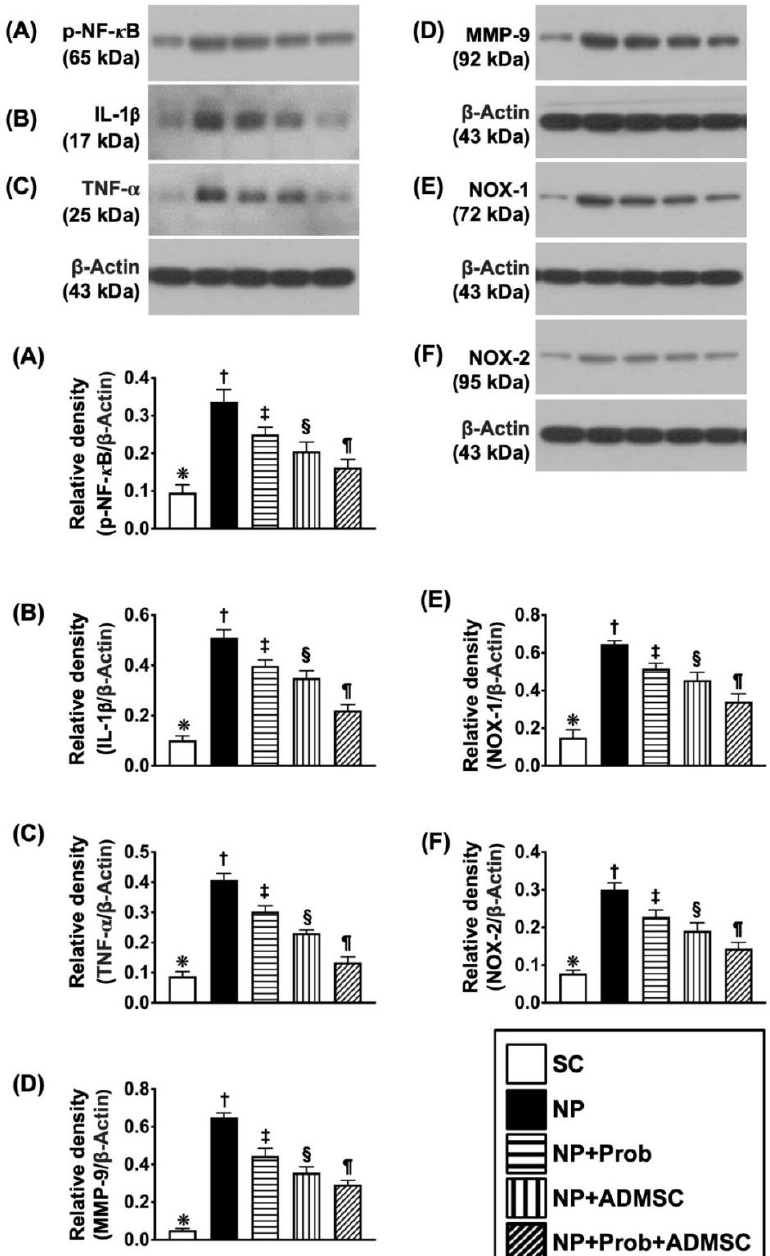
Figure 3. Protein expressions of inflammatory and oxidative stress biomarkers in ipsilateral L4-L5 dorsal root ganglia (DRGs) by day 60 after NP induction. ( A ) Protein expression of phosphorylated nuclear factor kapa B (p-NF- κ B), * vs. other groups with different symbols (†, ‡, §, ¶), p < 0.0001. ( B ) Protein expression of interleukin (IL)-1 β , * vs. other groups with different symbols (†, ‡, §, ¶), p < 0.0001. ( C ) Protein expression of tumor necrosis factor alpha (TNF- α ), * vs. other groups with different symbols (†, ‡, §, ¶), p < 0.0001. ( D ) Protein expression of matrix metalloproteinase (MMP)-9, * vs. other groups with different symbols (†, ‡, §, ¶), p < 0.0001. ( E ) Protein expression of NOX-1, * vs. other groups with different symbols (†, ‡, §, ¶), p < 0.0001. ( F ) Protein expression of NOX-2, * vs. other groups with different symbols (†, ‡, §, ¶), p < 0.0001. Symbols (*, †, ‡, §, ¶) indicate significance for each other (at 0.05 level). All statistical analyses were performed using one-way ANOVA followed by Bonferroni multiple comparison post hoc test (n = 6 for each group). SC = sham control; NP = neuropathic pain; Prob = probiotics; ADMSCs = adipose-tissue-derived mesenchymal stem